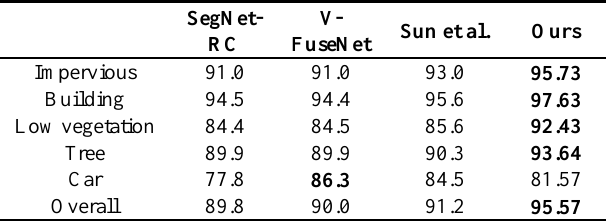
Table 3. F1 scores for each class and overall accuracies of different methods